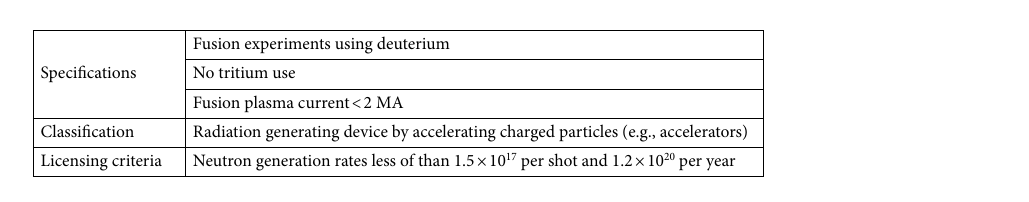
Table 1. KSTAR specifications and licensing criteria 18,19